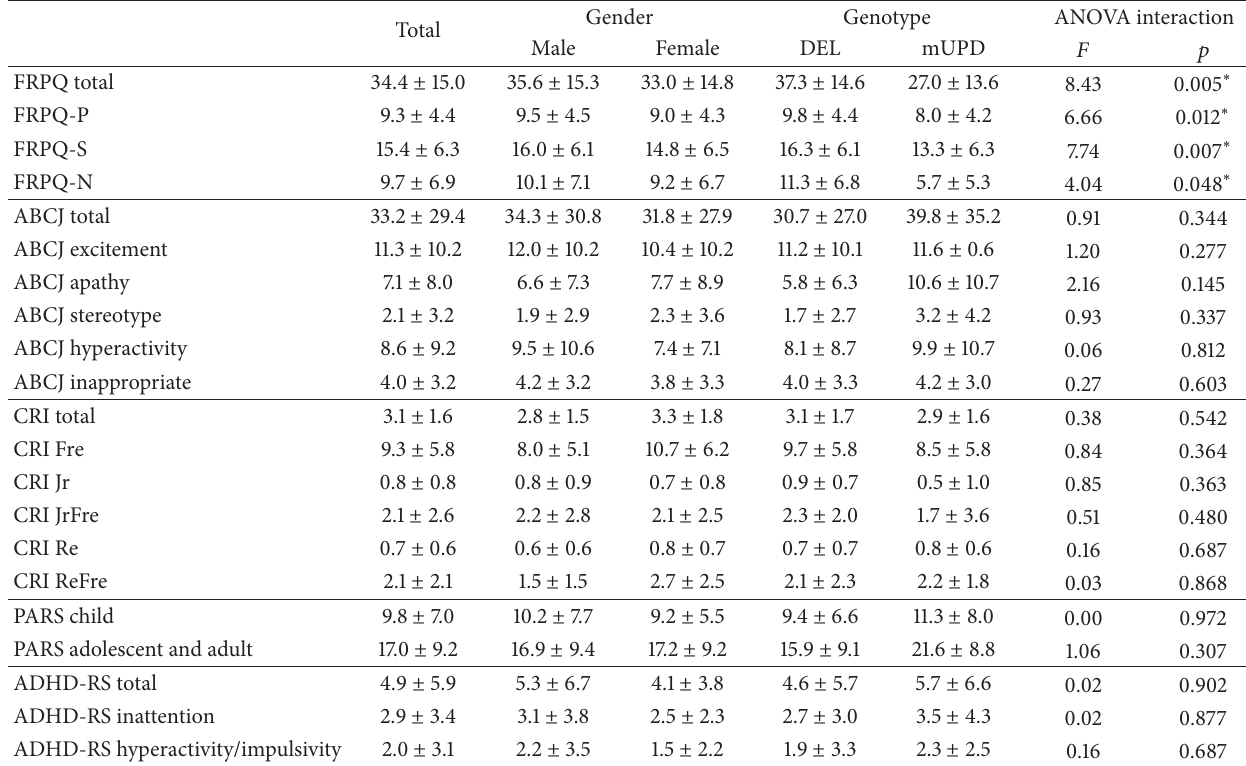
Table 2: The FRPQ, ABCJ, CRI, PARS, and ADHD-RS scores and the results of two-way ANOVA using the two gender groups and the two